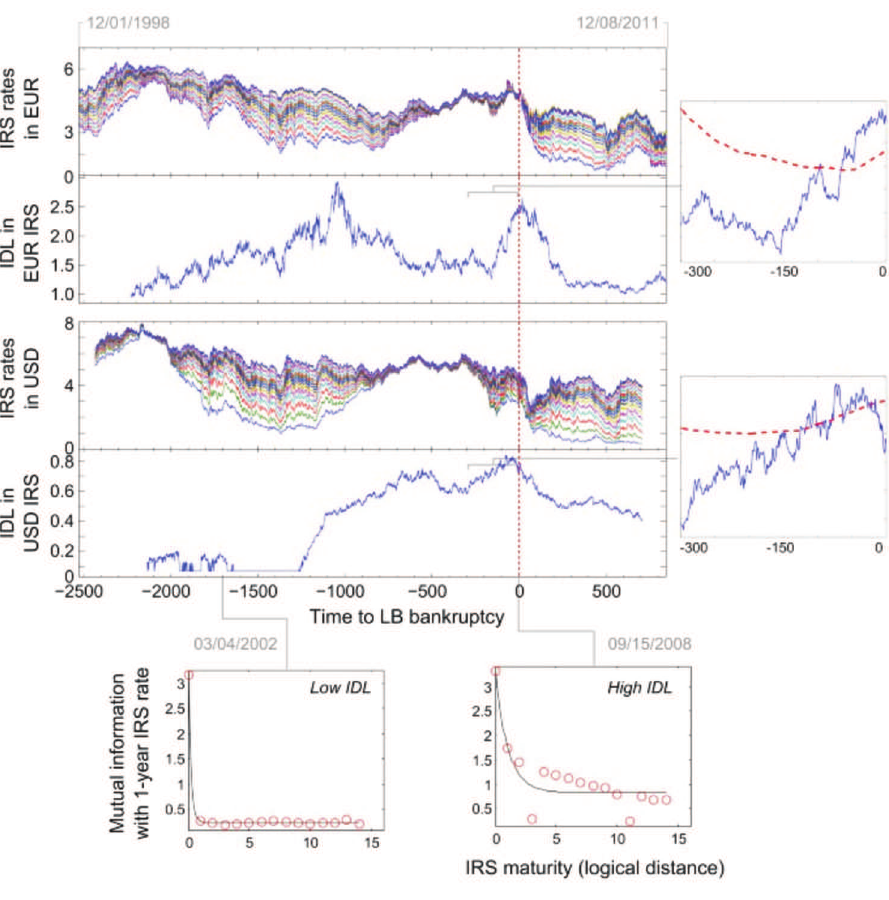
Chart 3 Illustration of the Quax, Khandai and Sloot hypothesis on the predictability of the Lehman Brothers collapse crisis through IDL